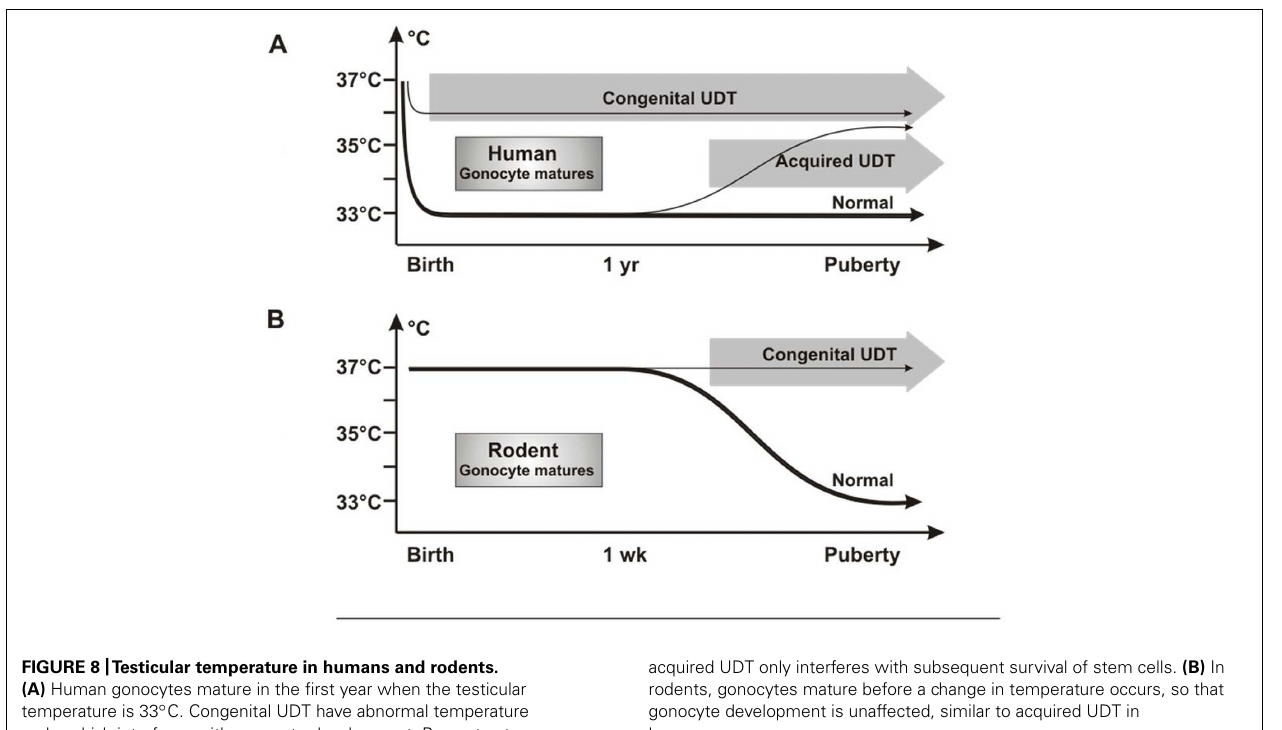
acquired UDT only interferes with subsequent survival of stem cells. (B) In rodents, gonocytes mature before a change in temperature occurs, so that gonocyte development is unaffected, similar to acquired UDT in